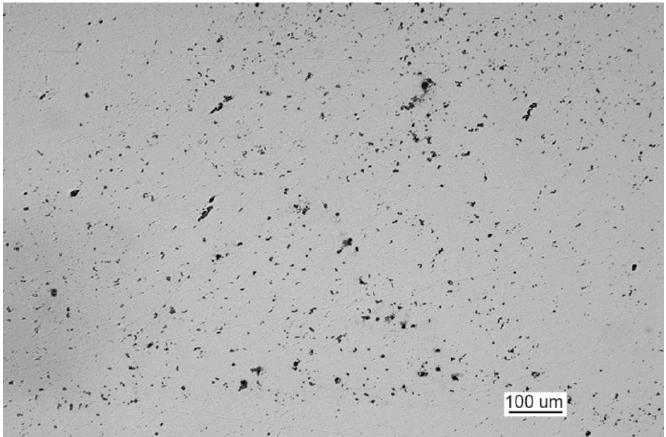
Figure 31. Non-etched metallographic specimen of part 1 showing the presence of spot-wise oxides (handy-size bulk carrier 30210